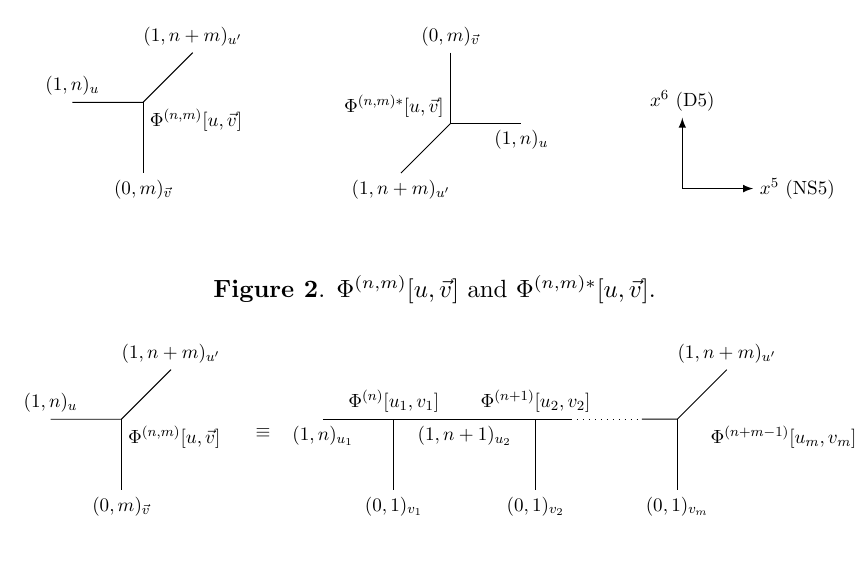
Figure 3 . Construction of the generalized intertwiners (cid:8) ( n;m ) [ u;~v